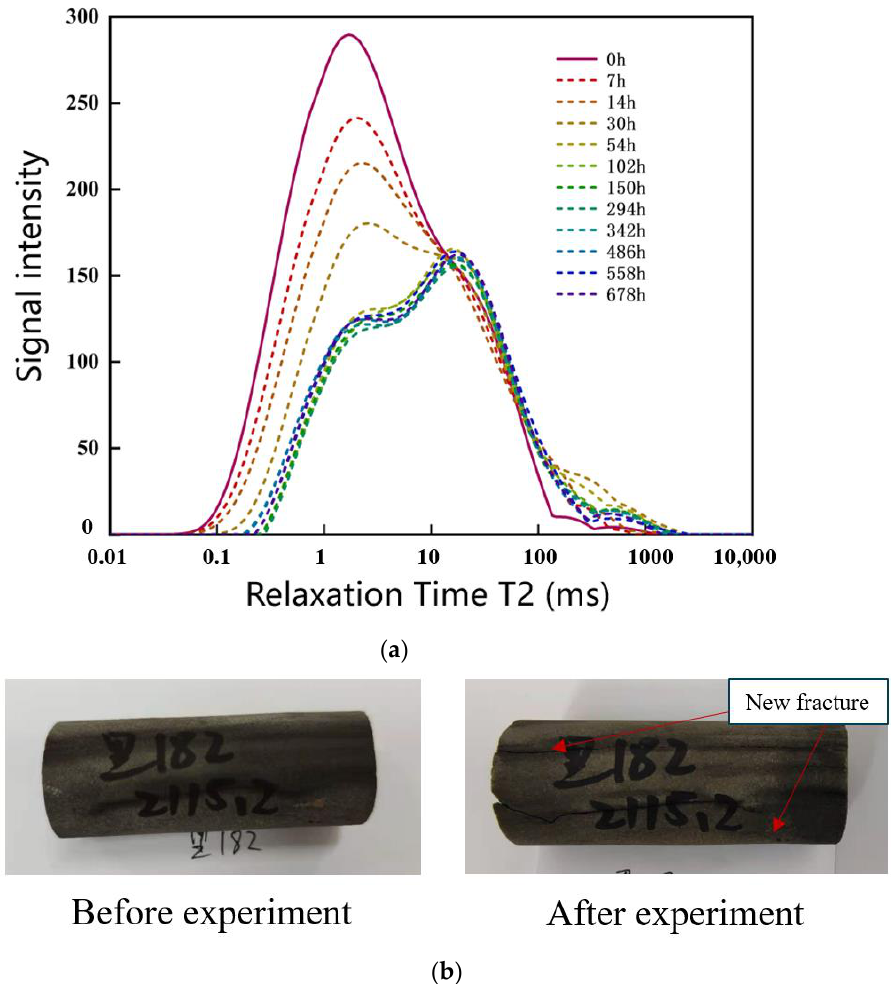
Figure 6. Development of T 2 of sample LBE at 1 atm. ( a ) The development of T2 over time; ( b ) The new fracture on the surface of the sample after the experiments.